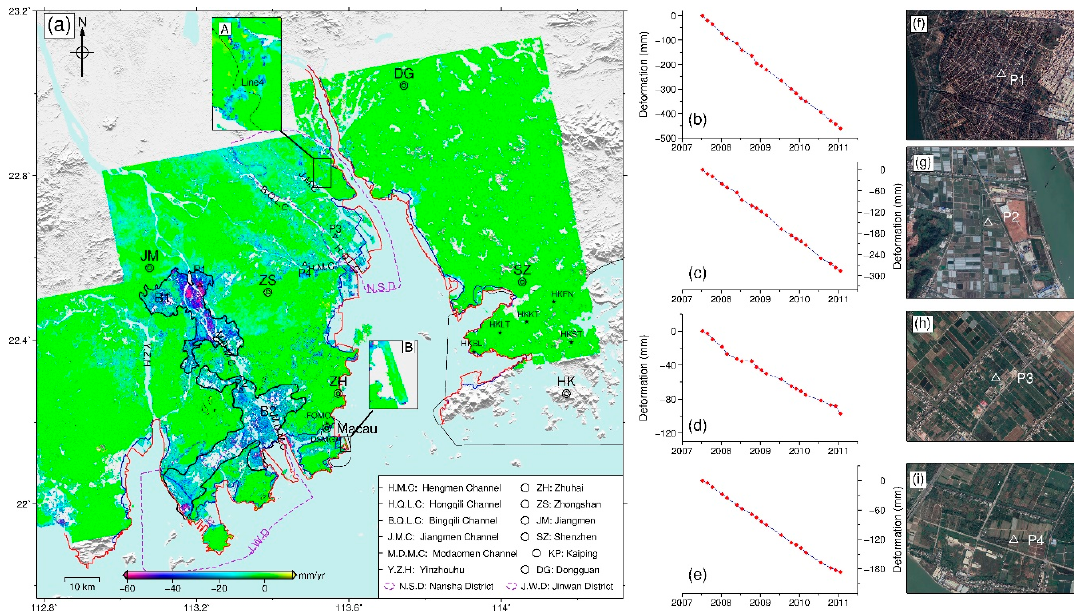
Figure 9. Average surface deformation map of the Pearl River Delta (PRD). Black solid circles B1 and B2 are two primary subsidence bowls with obvious deformation rates. Blue and red lines represent the coastlines in 1984 and 2011, respectively. Black stars represent the selected GPS stations. Purple dotted circles indicate the two selected districts, Jinwan (J.W.D) and Nansha (N.S.D). Black dotted circles represent the remaining topography-related atmospheric effects. Insets ( a , b ) are two selected urban areas. P1 and P2 are two selected points located in aquaculture lands, P3 and P4 are two points located in agricultural lands. ( b – e ) show the corresponding time series of the four selected points. ( f – i ) are the corresponding optical images for the four points.